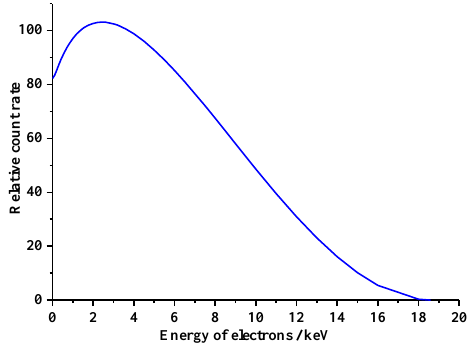
Figure 1. Beta energy spectrum of 3 H point source.